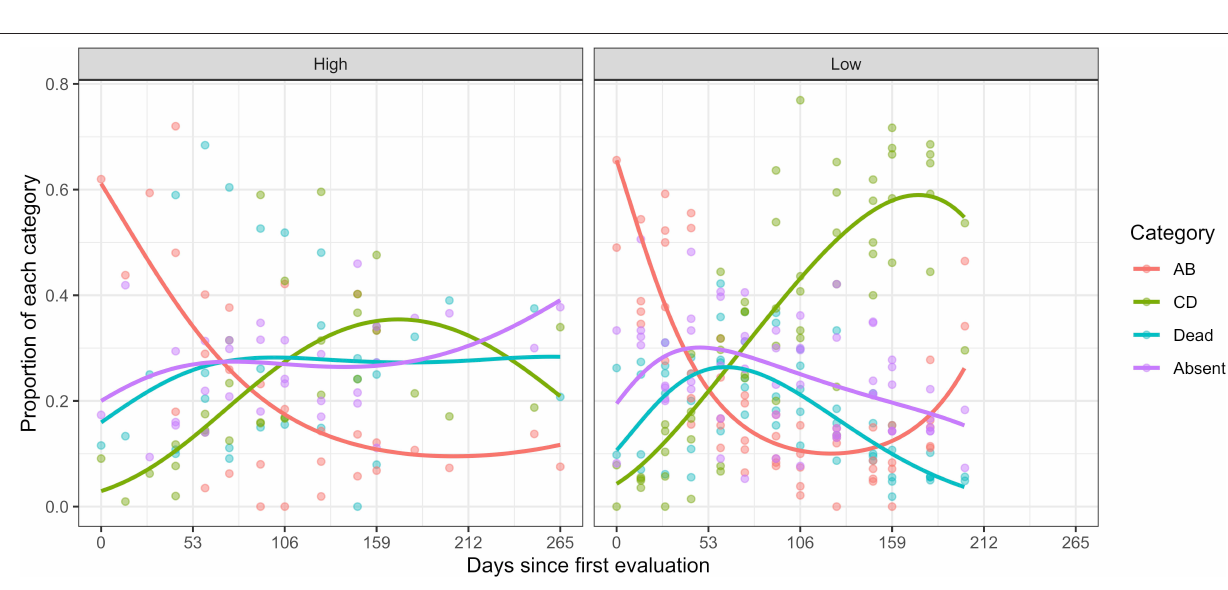
FIGURE 5 | Distribution of the CBB found inside the damaged berries from coffee farms in the Kona and Ka’u districts of Hawaii adopting calendar (high) and threshold (low) spray programs. Data points represent the proportions of CBB in each category, per sample date. The curves were obtained using multivariate linear models based on category proportions, including linear, and quadratic effects of